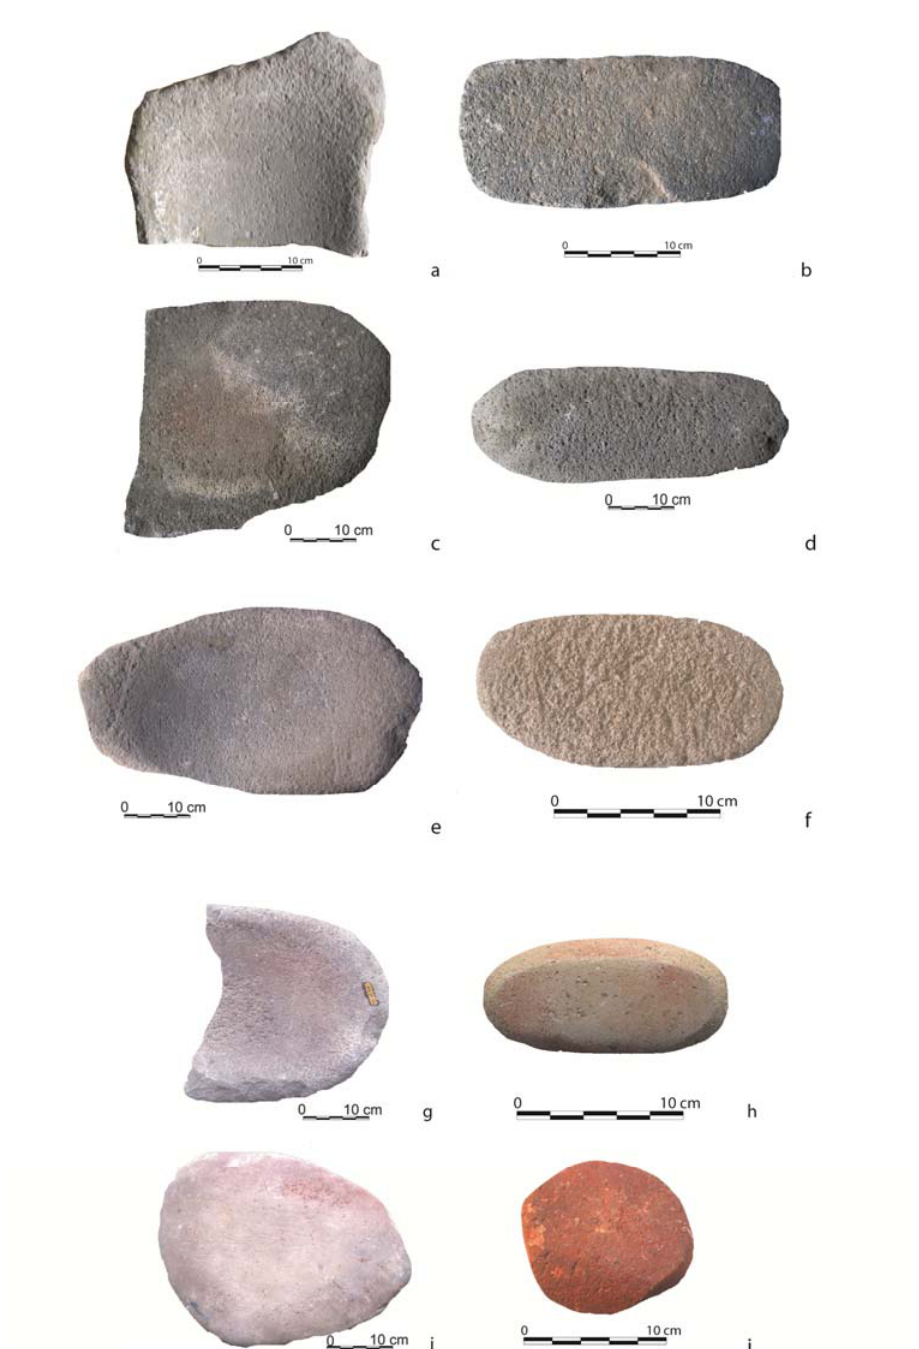
Figure 4. Late Neolithic from the middle Kura valley (Shulaveri group). Different grinding tools types: a. quadrangular concave quern used in back-and-forth motion (Shulaveri); b. loaf-shaped grinder (Imiris); c. flat ovoid quern (Imiris); d. narrow elongated grinder (Imiris); e. ovoid grinding slab (Imiris); f. short grinder (Shulaveri), h. ochre processing reused grinding slab (Shulaveri); i. handstones used for ochre fine grinding (Chramis Didi gora); j. grinding slab (Imiris); k. abrader ochre fragment (Chramis Didi gora) (photographs by C.